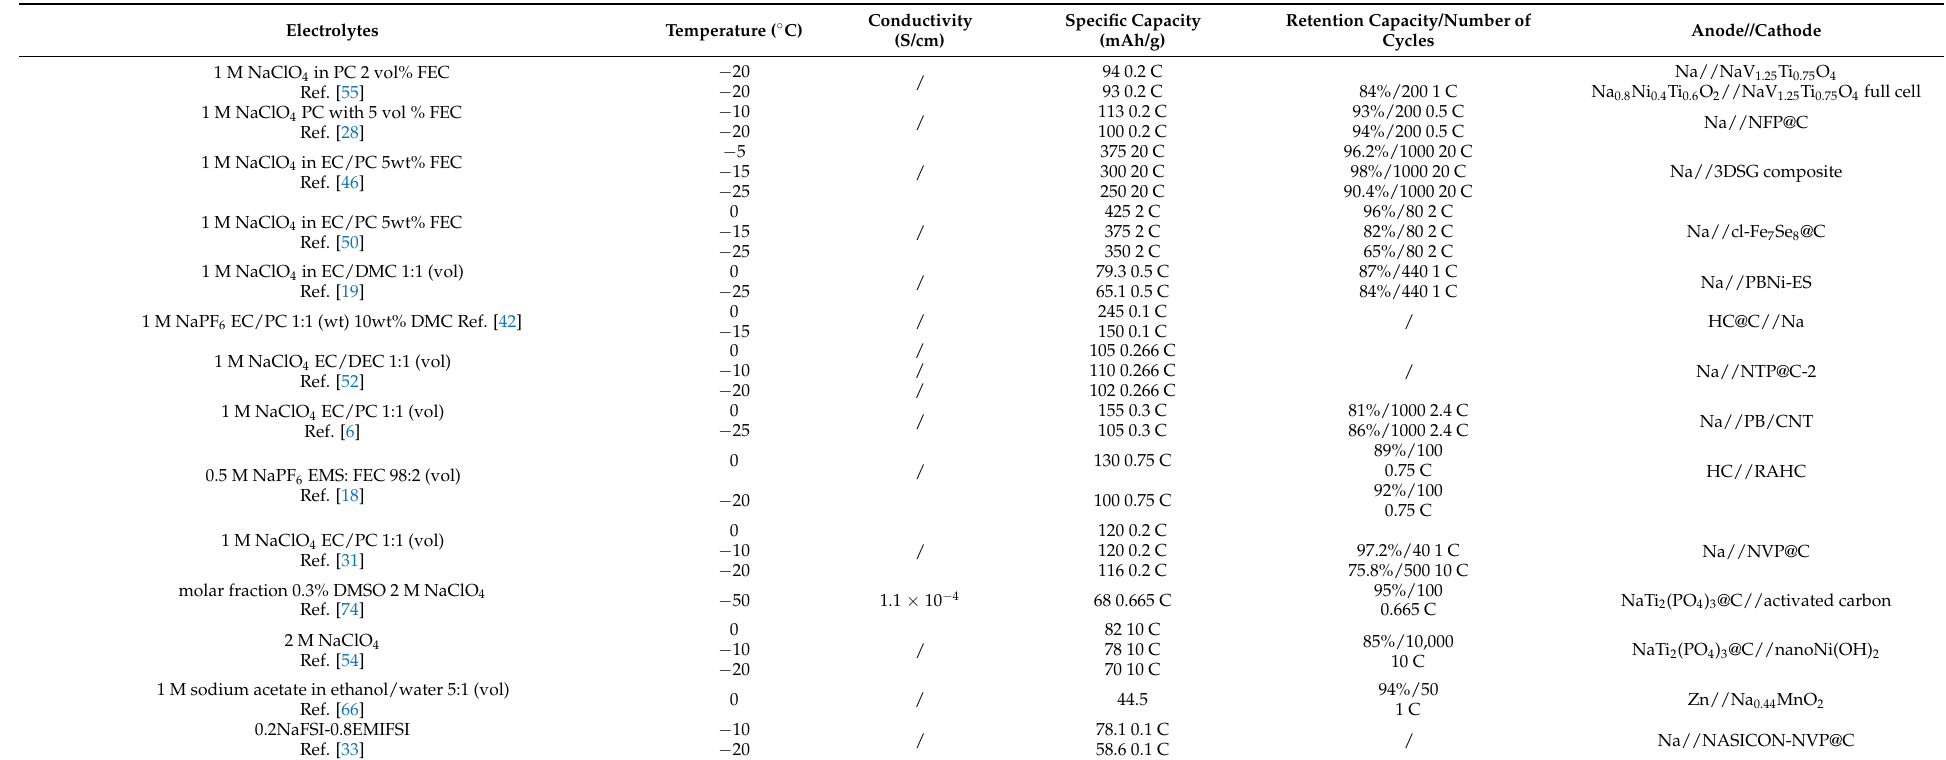
Table 1. Different electrolytes and their main low-temperature electrochemical